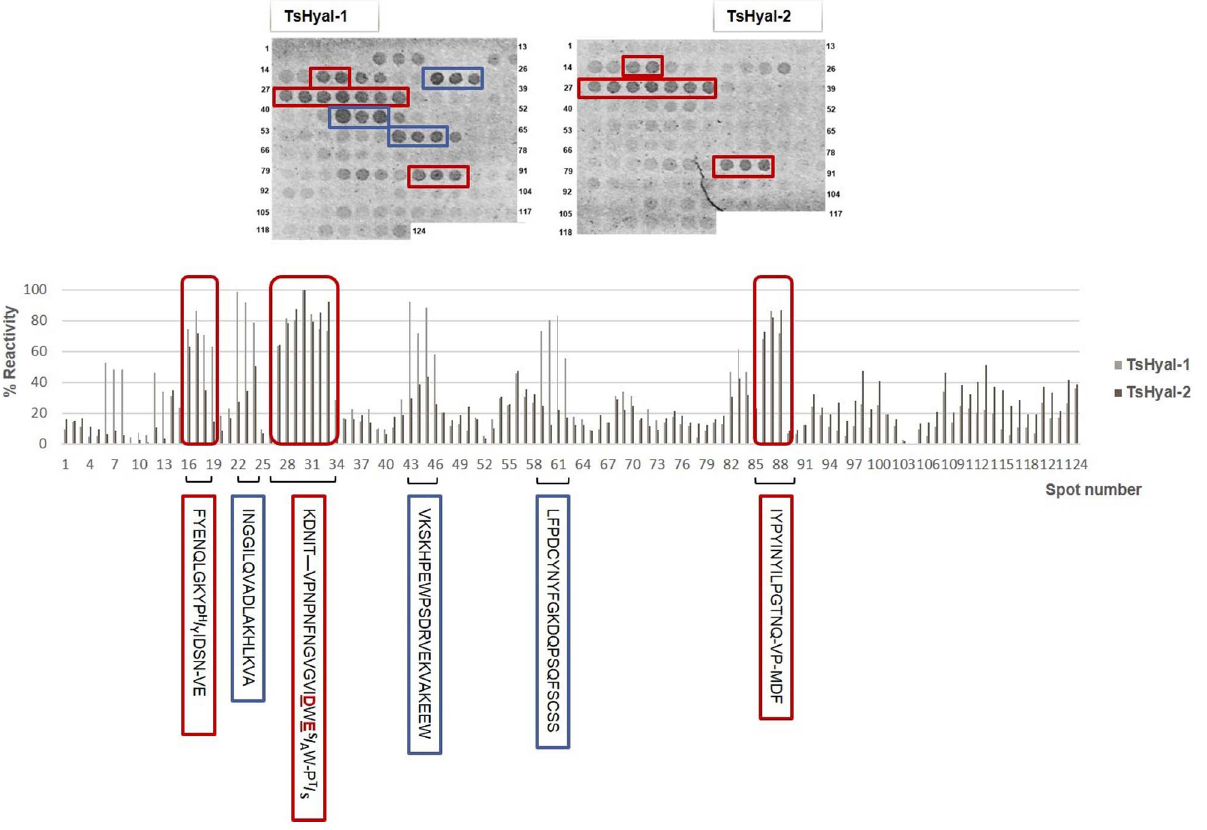
Figure 7. SPOT peptide immunoassay. Reactivity of rabbit anti-hyaluronidase serum to 15-mer overlapping synthetic peptides from the predicted amino acid sequences of TsHyal-1 and TsHyal-2. Peptides were immobilized onto cellulose membranes by the SPOT method, and membranes were probed with a 1:2,000 dilution of rabbit anti-hyaluronidase serum and a 1:4,000 dilution of alkaline phosphatase-conjugated anti- rabbit antibodies. Spot intensities were quantified and graphed as percent reactivity against the TsHyal-1 and TsHyal-2 peptide spots. Six antigenic regions with serum reactivities higher than 60% were identified. Three were common to TsHyal-1 and TsHyal-2 (red squares), and three were unique to TsHyal-1 (blue squares). The active site residues D 101 and E 103 are marked in red.